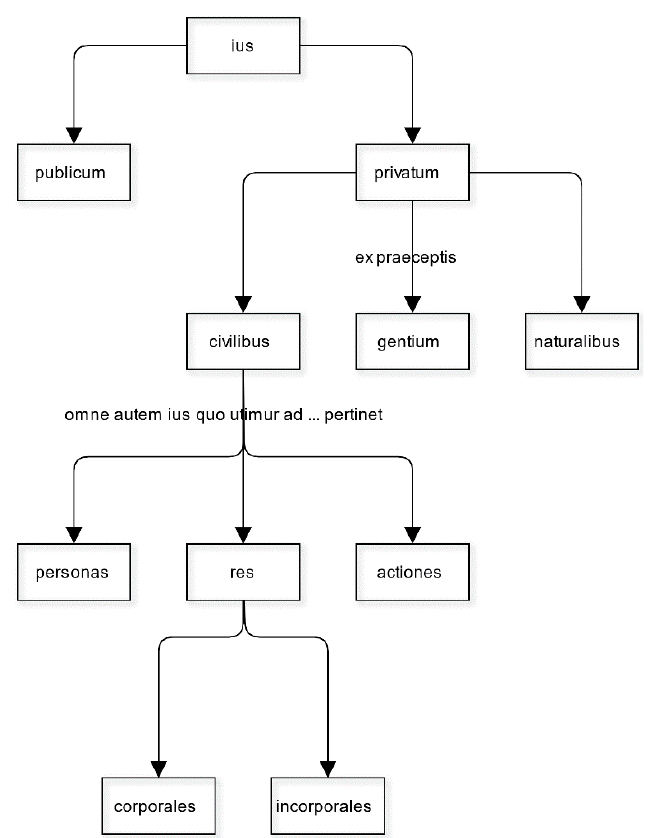
Figure 7. The institutional structure of law according to Justinian’s Institutes 1.1 (533 CE) and the Institutes of Gaius 2.12–14 (165 CE).